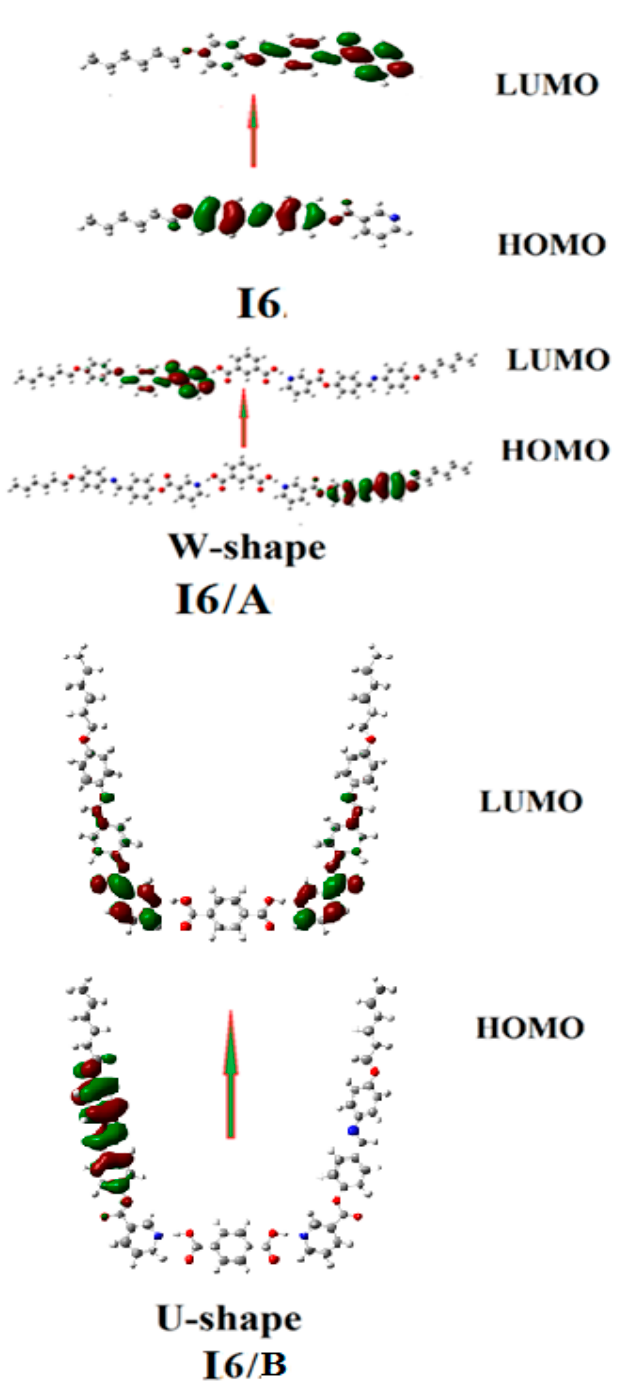
Figure 5. The estimated plots for frontier molecular orbitals of the I6/A and I6/B SMHBCs.